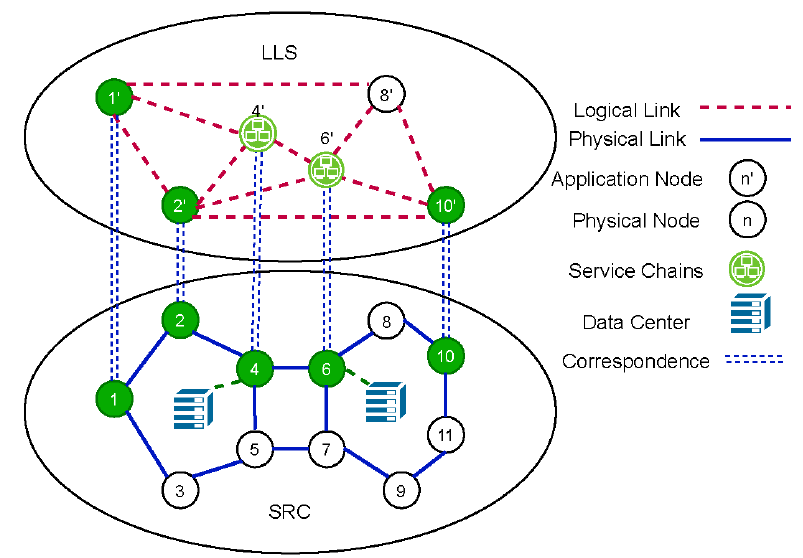
Figure 5. Cross-layer model.